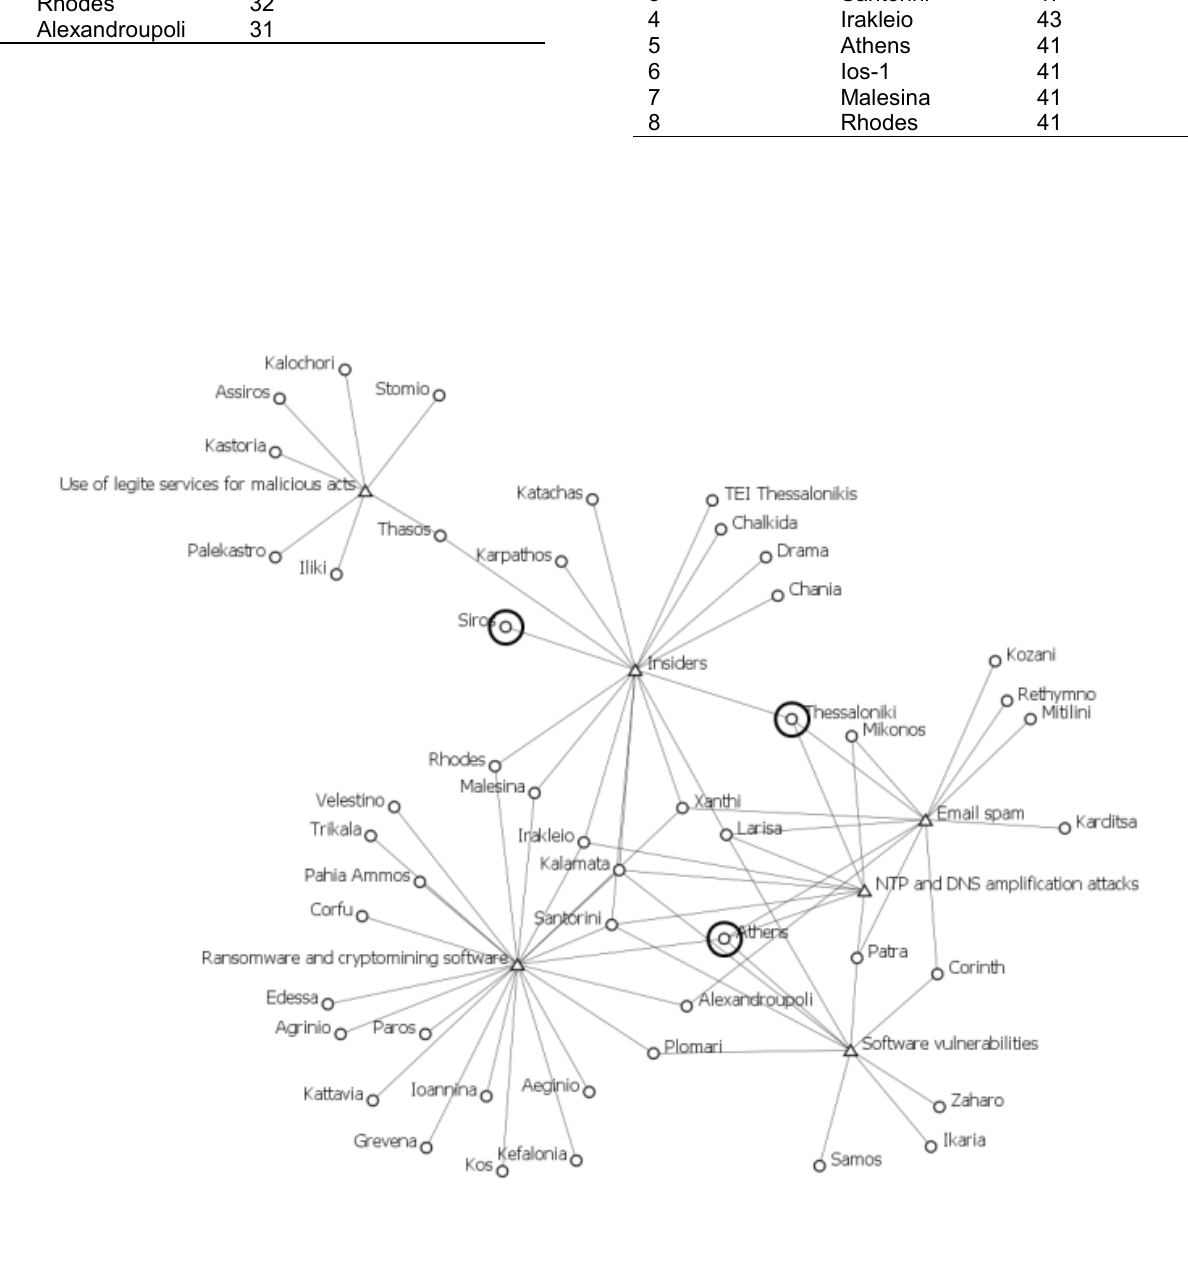
Figure 3. |A| x |R| affiliation